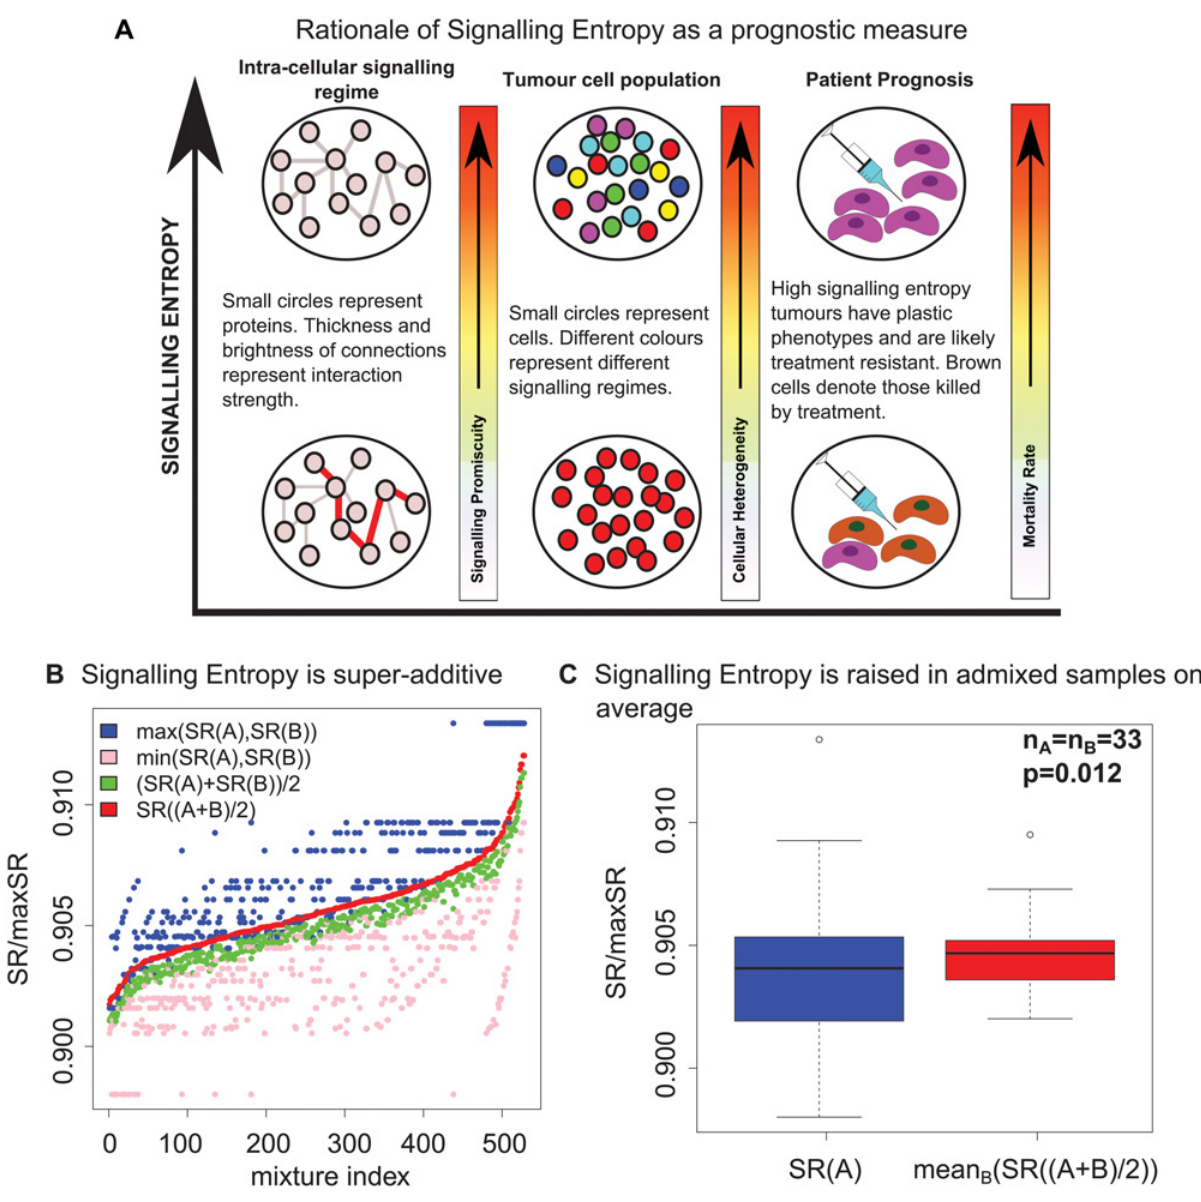
Fig 1. Rationale behind signalling entropy as a prognostic factor in cancer. A) A high signalling entropy of a tumour sample indicates a promiscuous, stem cell like intra-cellular signalling regime and a heterogeneous cancer cell population. The consequence of a high entropy is thus a tumour with a plastic phenotype, capable of activating diverse pathways in response to treatment. High signalling entropy tumours are thus likely to result in higher patient mortality. B) Signalling entropy (denoted SR/max SR) computed for 528 distinct pairwise mixtures of 33 homogeneous tissue samples reveals that our measure is super-additive and hence will be raised, on average, in mixed samples compared to homogeneous samples. C) Signalling entropy is raised on average in mixed samples as compared to homogeneous samples, considering the same 33 homogeneous tissue samples as Fig. 1B. The p -value corresponds to a two tailed paired Wilcoxon signed rank test, and reveals that signalling entropy is significantly elevated in the admixed cell populations on average.